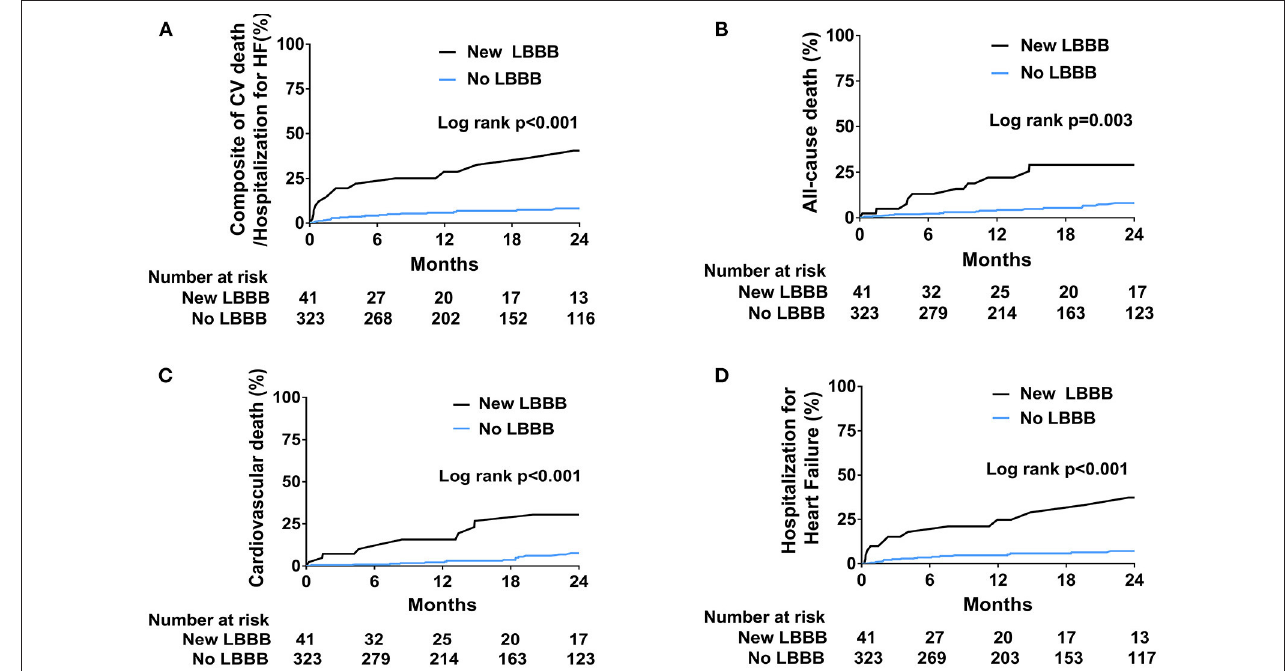
FIGURE 2 | Kaplan-Meier curves for the incidence of clinical outcomes. (A) Composite of cardiovascular death and hospitalization for heart failure. (B) All-cause death. (C) Cardiovascular death. (D) Hospitalization for heart failure.